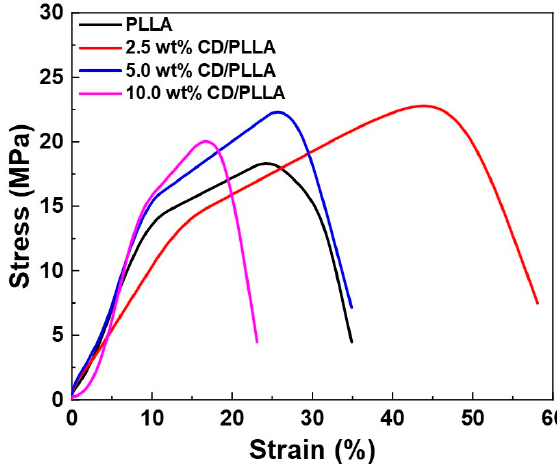
Figure 7. Stress-strain curves of PLLA and CD/PLLA nanofibers.